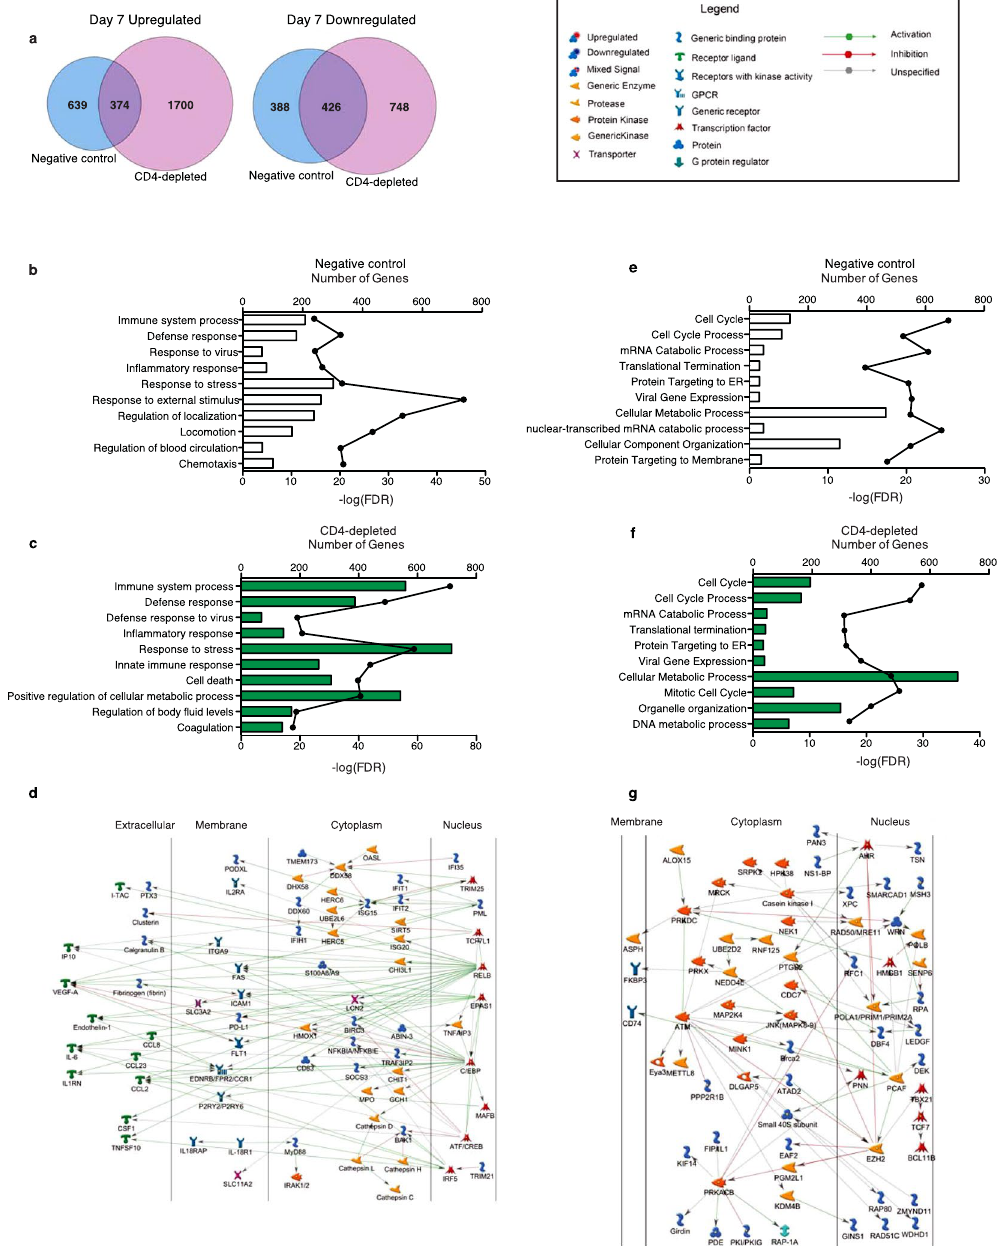
Figure 4. Negative control and CD4-depleted animals show transcriptional changes consistent with hemorrhagic fever on the day they succumb to EBOV challenge. ( a ) Venn diagram comparing upregulated and downregulated genes in negative control and CD4-depleted animals on the day of euthanasia. ( b , c ) Bar graph depicting the most statistically significant GO terms to which upregulated DEGs in negative control animals ( b ) and CD4-depleted animals ( c ) enriched on the day of euthanasia. ( d ) Network depicting direct interactions of common upregulated genes between negative control and CD4-depleted animals that map to “Immune System Process”. ( e , f ) Bar graph depicting the most statistically significant GO terms to which downregulated DEGs in negative control animals ( e ) and CD4-depleted animals ( f ) enriched on the day of euthanasia ( g ) Network depicting direct interactions of downregulated genes in both groups that map to “Cellular Metabolic